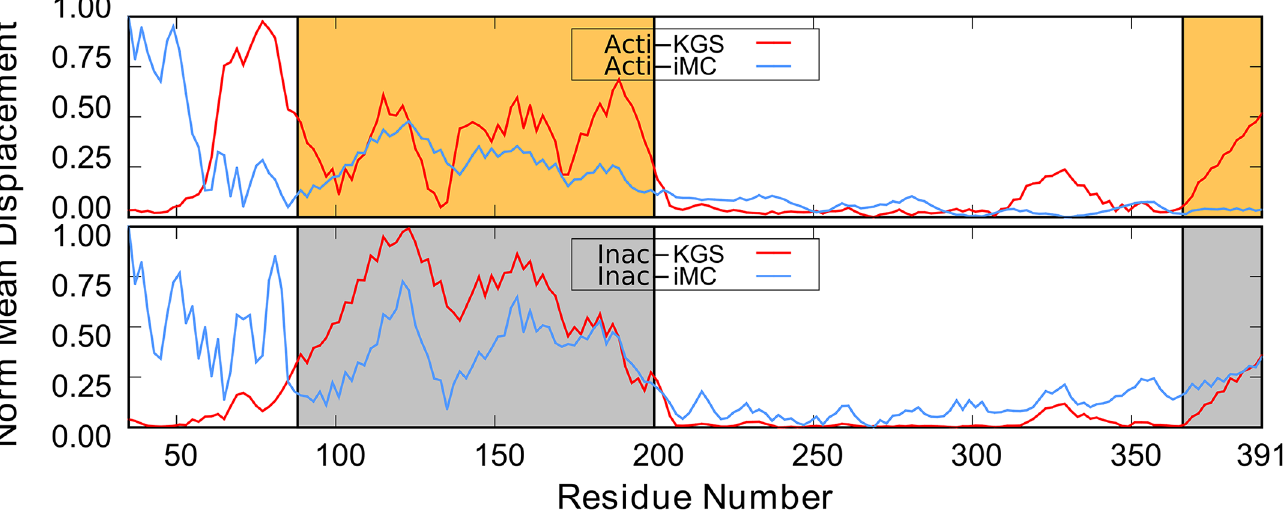
Fig 7. The normalized magnitude of the mean C α displacement vectors of the KGS and iMC ensembles. The top panel shows the normalized displacements for the active state KGS and iMC ensembles. The bottom panel for the inactive state. The AH-domain is indicated by orange (active) or grey (inactive) shading. The α 5 helix is shaded in the same color on the far right. The location of the N-terminal part of α 4 helix in the Ras-domain is indicated by a pronounced “ bump ” in between residues 320 and 340 for the KGS ensemble